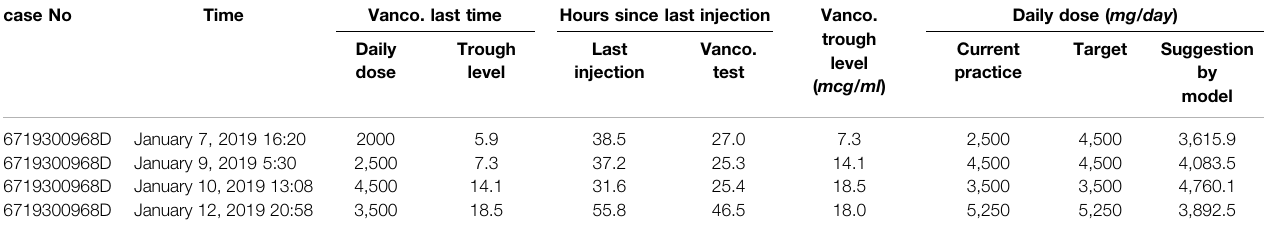
TABLE 6 | Examples of the subsequent dose model showing different target daily doses and suggested daily